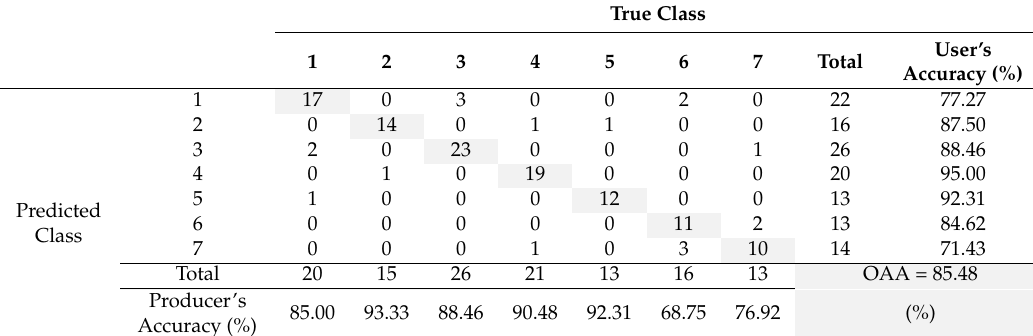
Table 7. Error matrix (accuracy assessment report) made for the classified LULC analysis.